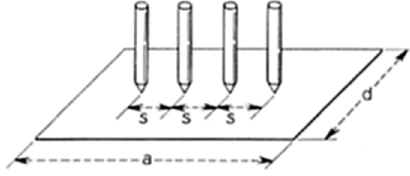
Figure 5. Four ‐ point probe method. Figure 5. Four-point probe method.